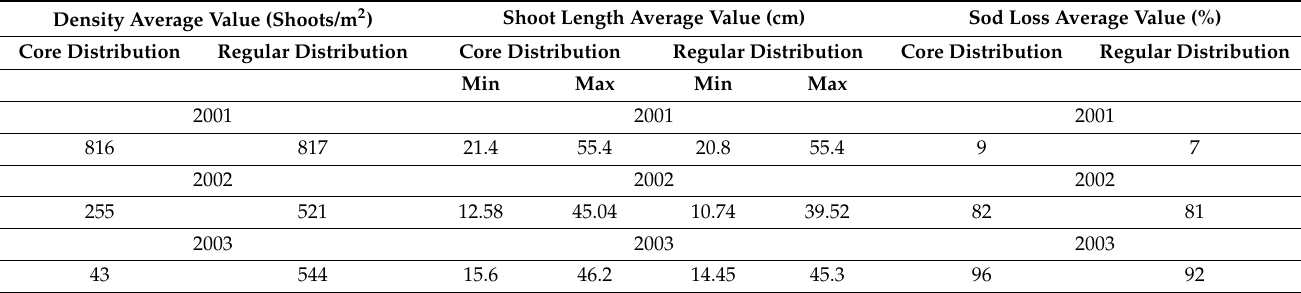
Table 4. Average values of density, leaf length and sod loss in the monitoring